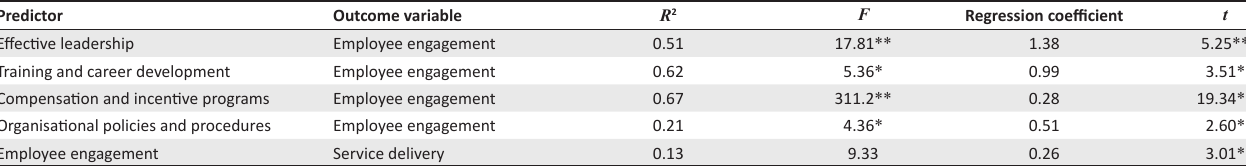
TABLE 5: Regression analysis. Predictor